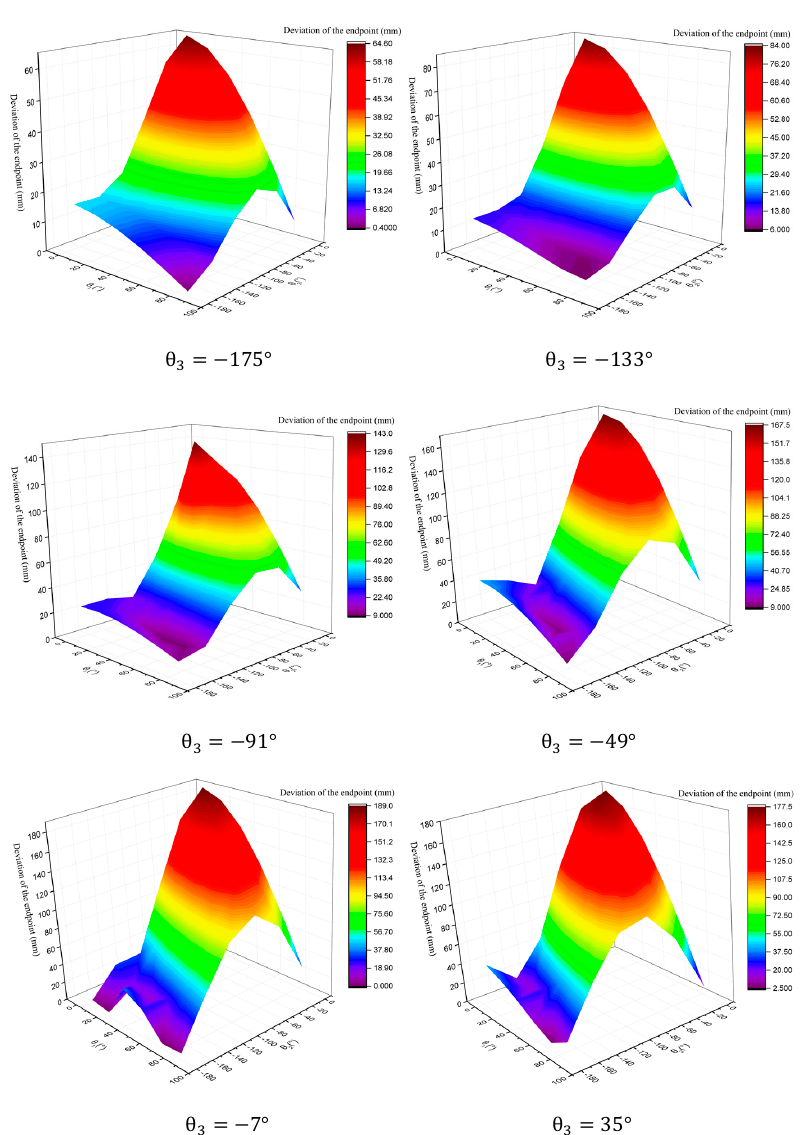
Figure 6. Relationship of endpoint deviation and each joint angle.